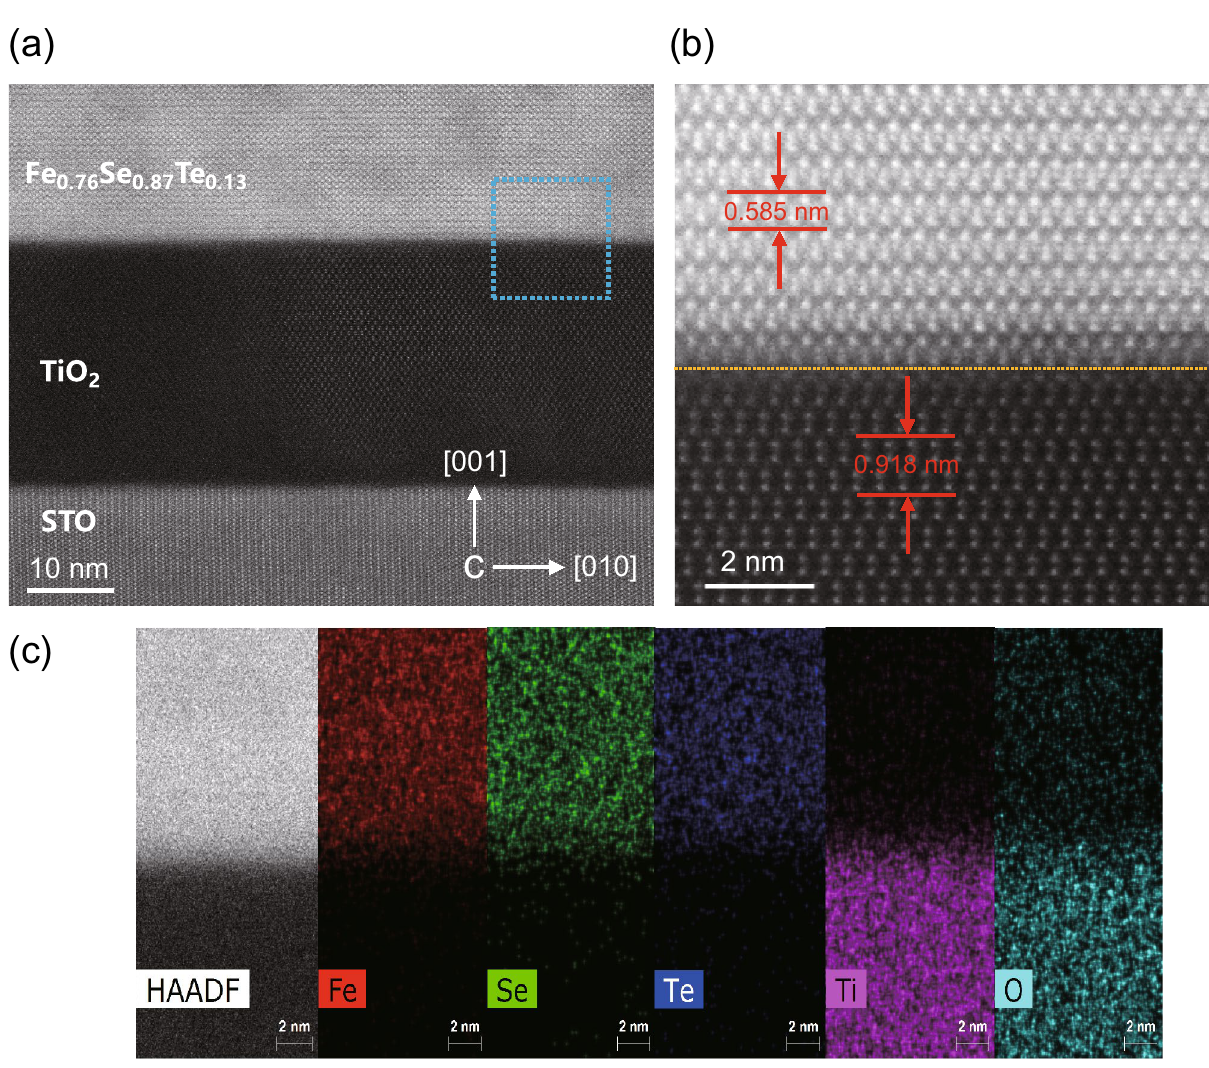
Figure 8. ( a ) Overview image of the Fe 0.76 Se 0.87 Te 0.13 /TiO 2 /STO thin film interface. ( b ) Atomically resolved HADDF-STEM image of